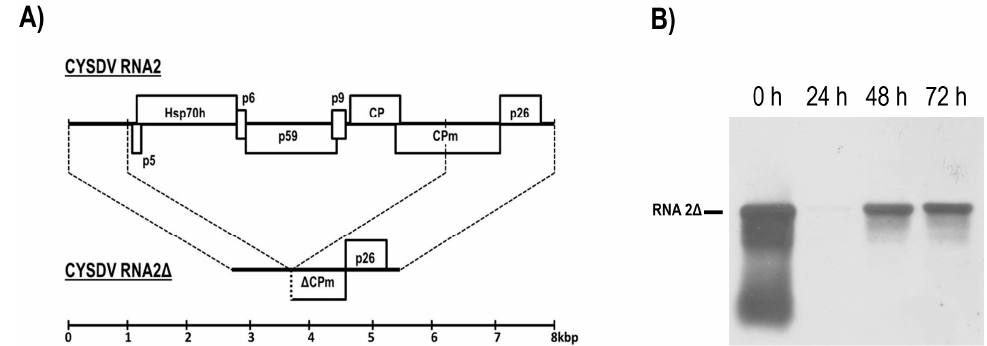
Figure 3. An artificial defective RNA2 transcript replicates in cucumber protoplasts in the presence of RNA1. ( A ) Schematic showing the relationship between CYSDV RNA2 and RNA2 Δ , a deletion mutant created by removing nucleotides 1116–6325 of CYSDV RNA2; ( B ) a time-course northern blot of total RNA extracted from the protoplasts co-transfected with equimolar amounts of CYSDV RNA1 and RNA2 Δ , hybridised with a dig-labelled riboprobe of the ( − ) sense CYSDV p26 gene. The position of RNA2 Δ is indicated.